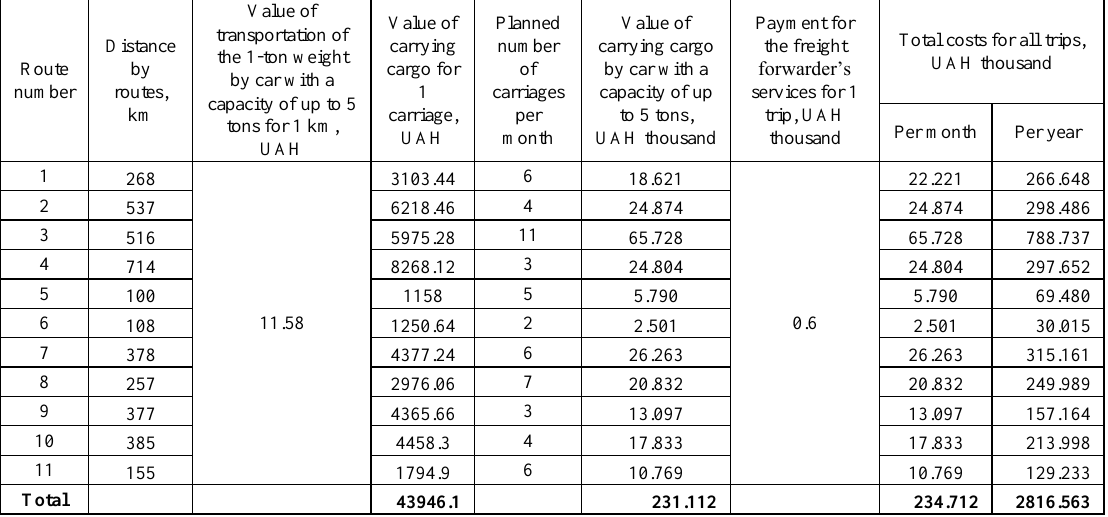
Table 4. Total annual costs for the purchase and transportation of raw